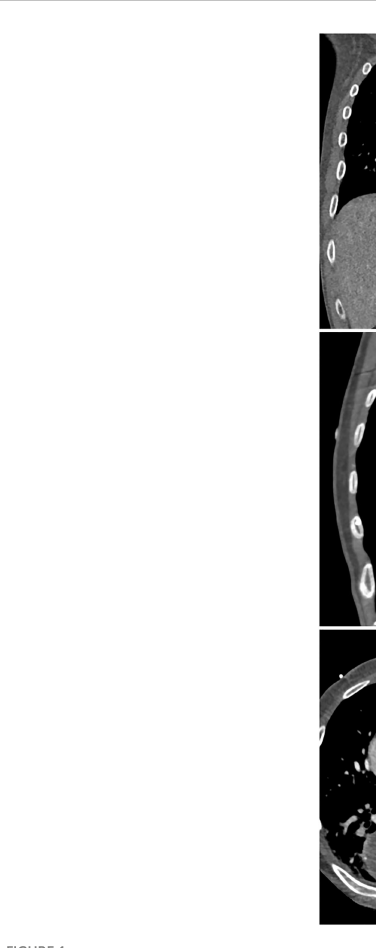
FIGURE 1 Triple-rule-out CT imaging of the described patient in coronal (A, B) , sagittal (C, D) , and transverse (E, F) reconstructions. (A, B) show a left-sided tension pneumothorax with mediastinal displacement to the left. In the hiatal area, torsion of the transverse colon and mesocolon reveals a closed- loop obstruction. A density-increased pleural effusion and dilated transverse colon in the left hemithorax can be seen (C-F) , suggesting a colonic perforation as cause for